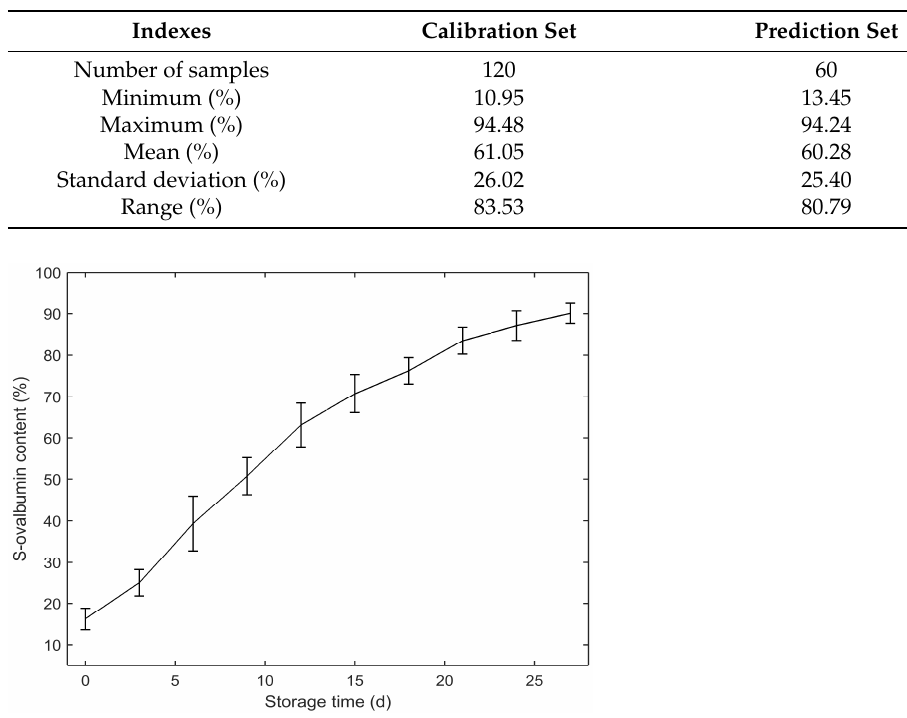
Table 1. Reference S-ovalbumin content of egg samples measured by spectrophotometry.